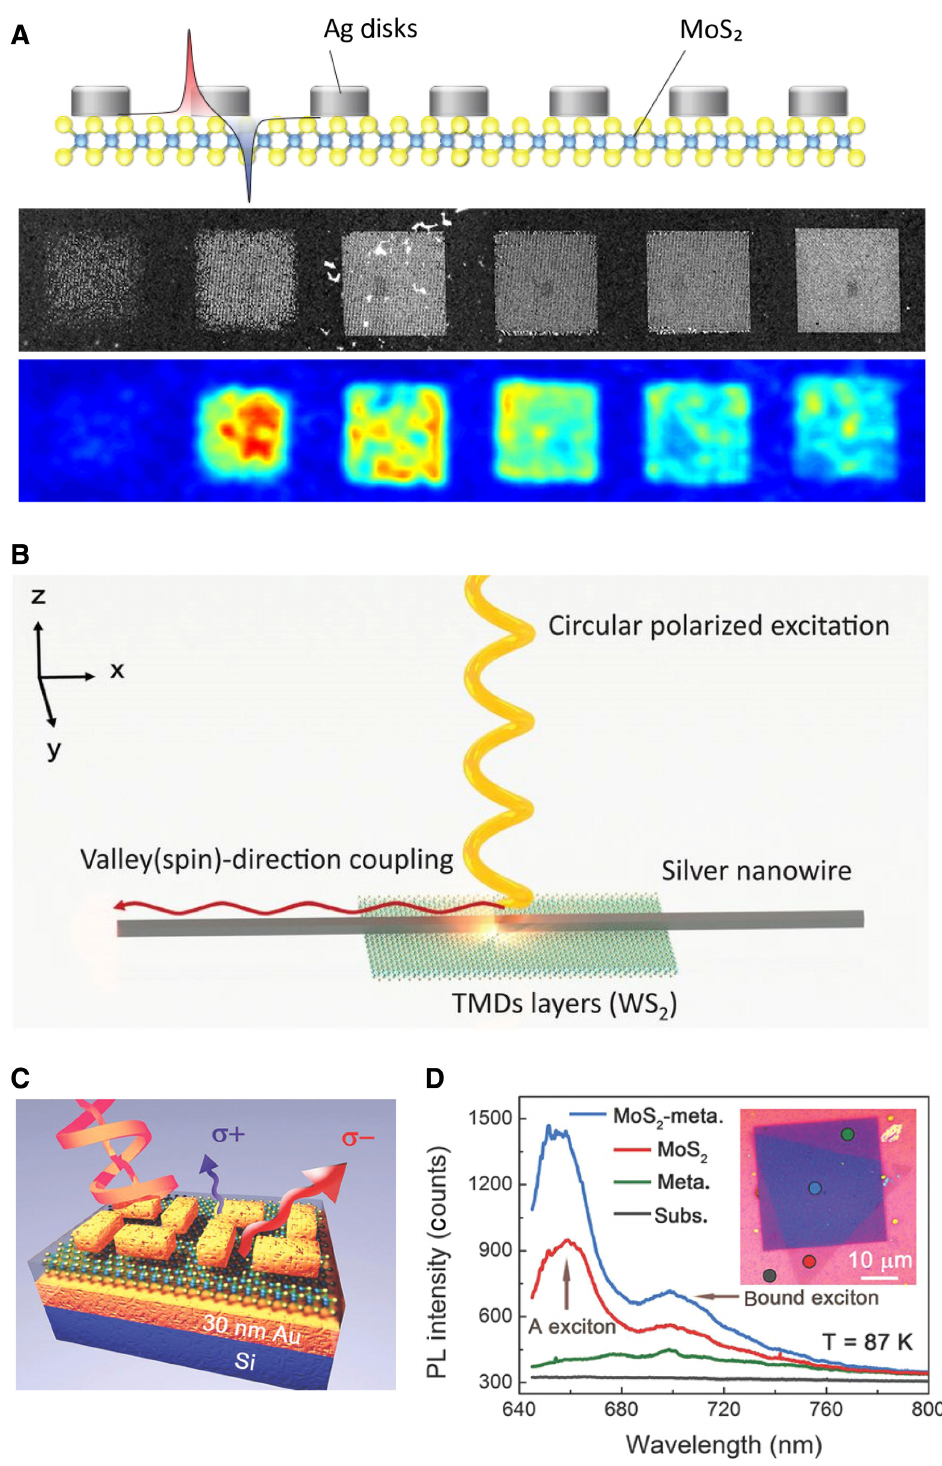
Figure 3: Enhancing PL of 2D materials by plasmonic nanostructures. (A) Enhanced light emission from large-area monolayer MoS using plasmonic silver nanodisc arrays, where enhanced PL up to 12 times 2 was measured. (B) The valley-dependent directional coupling of light using a plasmonic nanowire–WS system. It shows that the 2 valley pseudospin in WS couples to transverse optical spin of the same handedness with a directional coupling efficiency of 90 ± 1%. 2 (C) Schematic of the resonant field of the chiral metasurface coupled with valley-polarized excitons. (D) The WoS metacoupling tailors the 2 measured PL spectra in the far field at T = 87 K where the PL intensity of MoS monolayer is enhanced by the chiral metasurface, see the 2 inset optical image. Reproduced/adapted with permission from Butun et al. [102] (A), Gong et al. [103] (B), and Li et al. [104] (C,